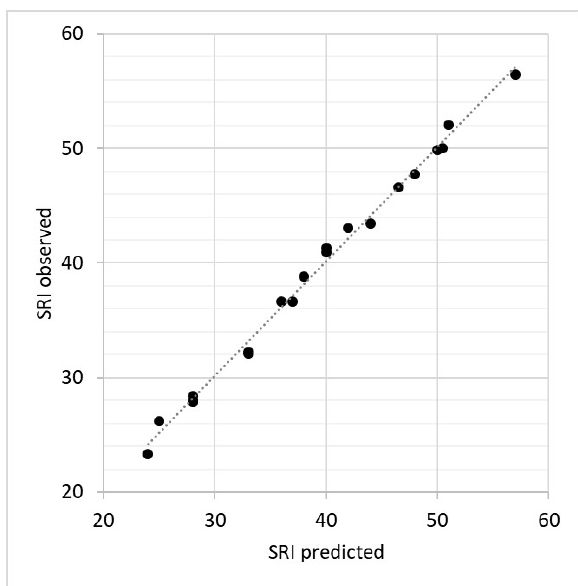
Fig. 2. Scatter plot of SRI 3 observed and